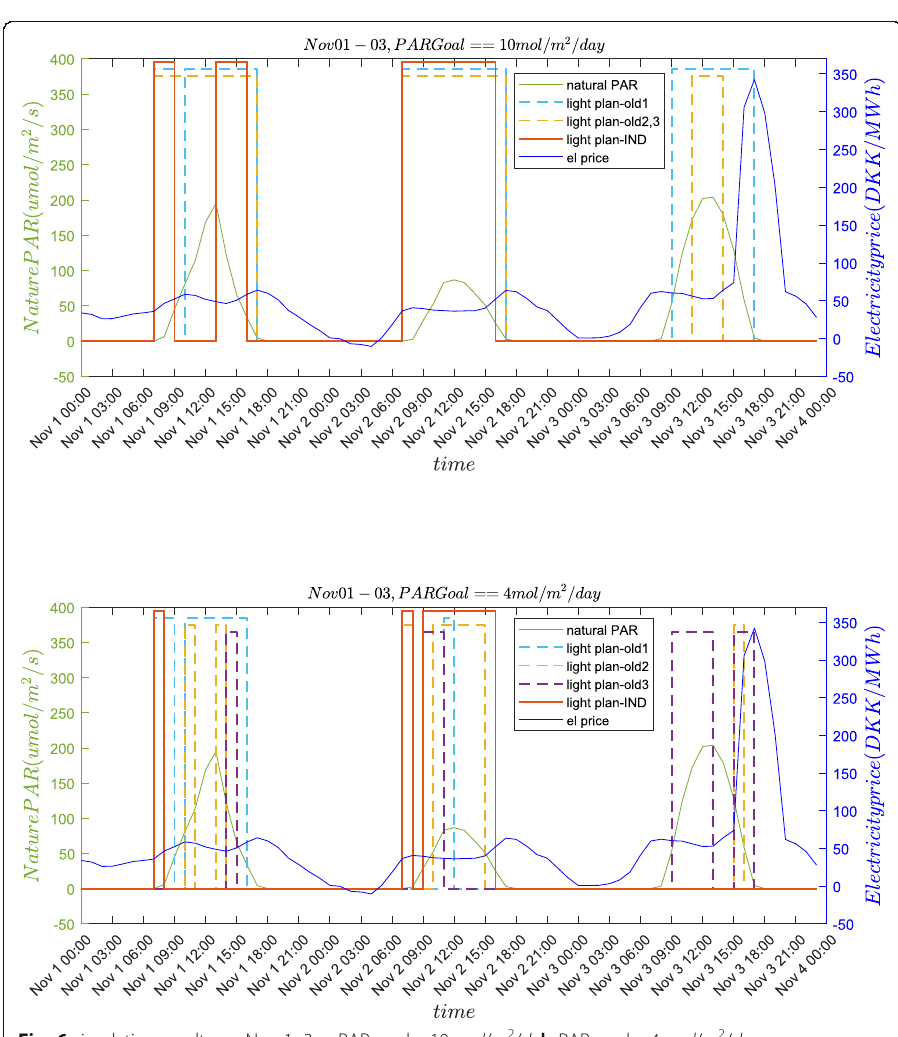
Fig. 6 simulation results on Nov 1 – 3. a PAR goal = 10 mol / m 2 / d . b PAR goal = 4 mol / m 2 /